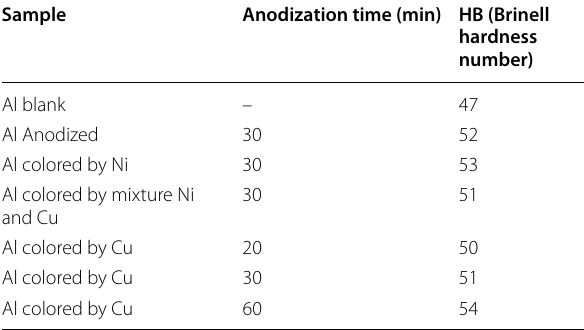
Table 6 Measurements of surface hardness after electrolytic coloring of Al